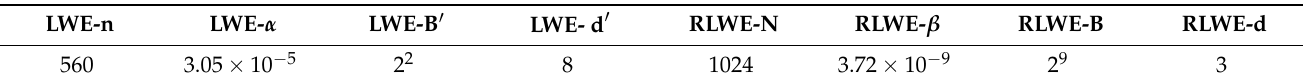
Table 4. Parameter